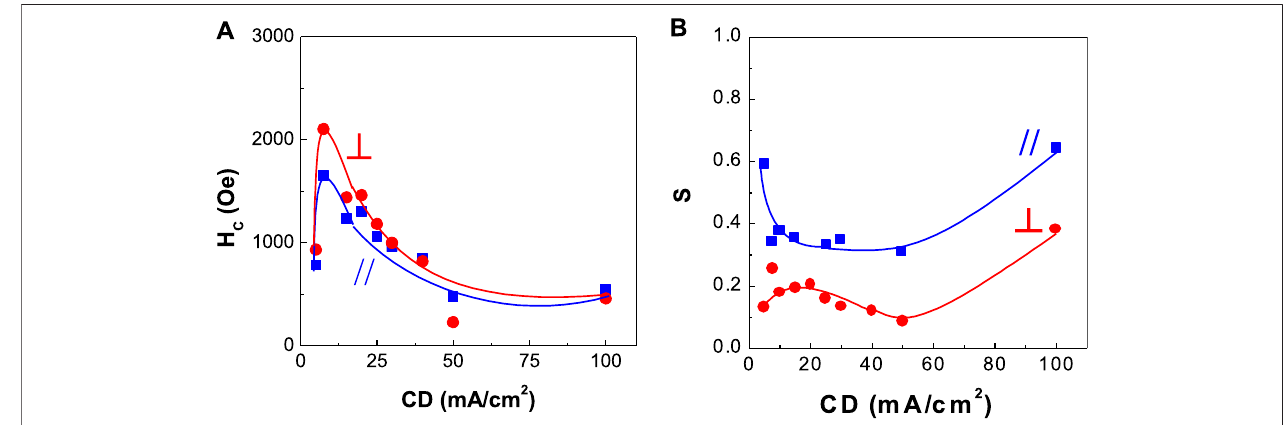
FIGURE 7 | Dependence of coercivity and squareness of CoPt thin fi lms on current density (CD) (A) coercivity and (B) squareness.